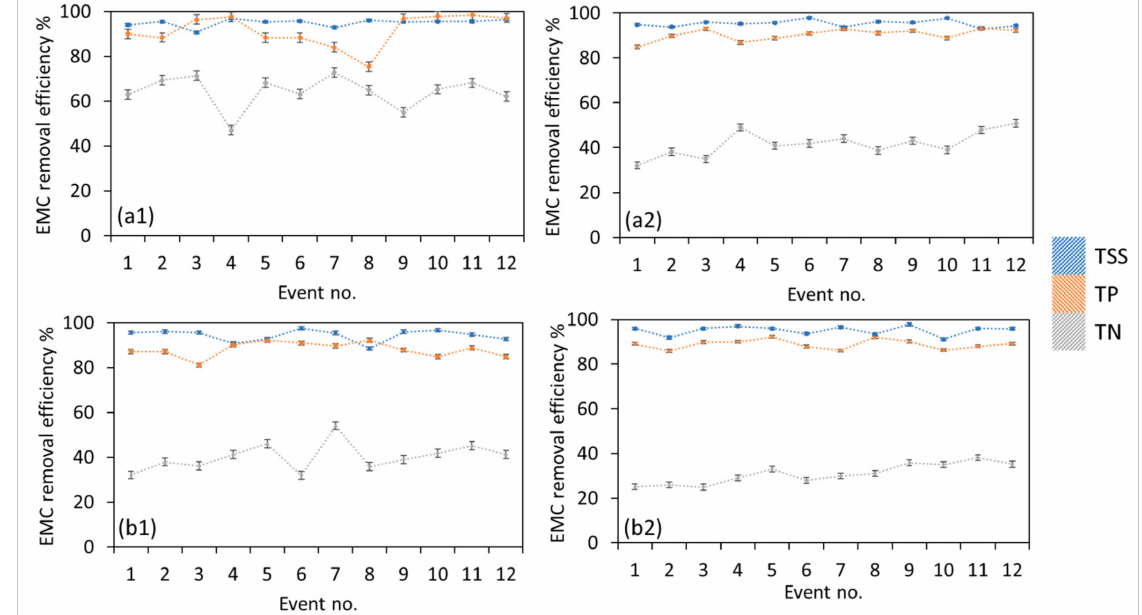
Figure 5. Phase 2 EMC removal efficiency of TSS, TP and TN for ( a1 ) TT1 in dry condition, ( a2 ) TT2 in dry condition, ( b1 ) TT1 in wet condition, ( b2 ) TT2 in wet